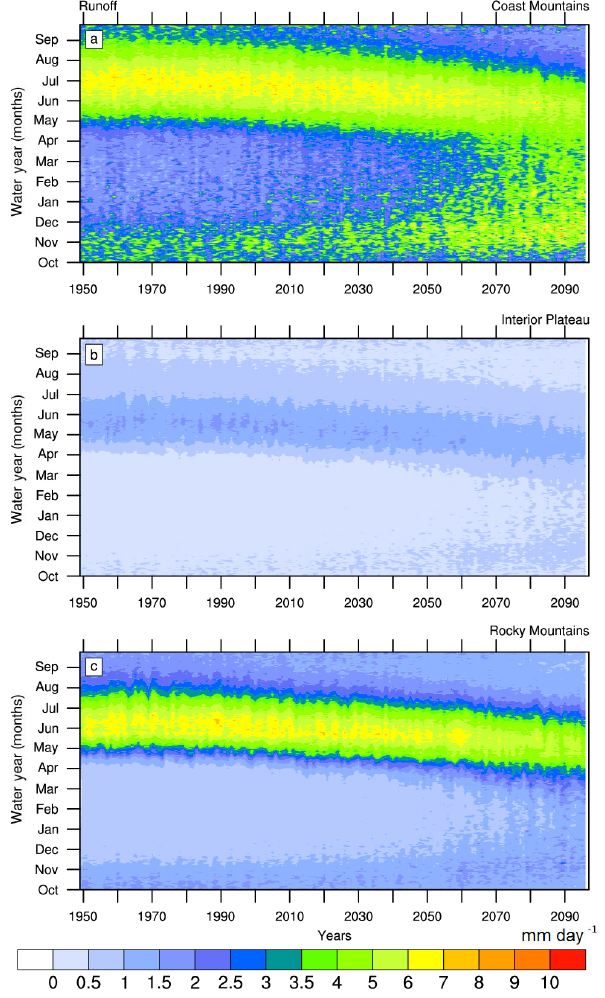
Figure 6. CMIP5-VIC-simulated MME mean daily runoff for the Coast Mountains (a) , Interior Plateau (b) and Rocky Mountains (c) . Values are spatial averages over geoclimatic regions. Units are mmday − 1 . Runoff units are an equivalent regional average rainfall rate rather than a discharge